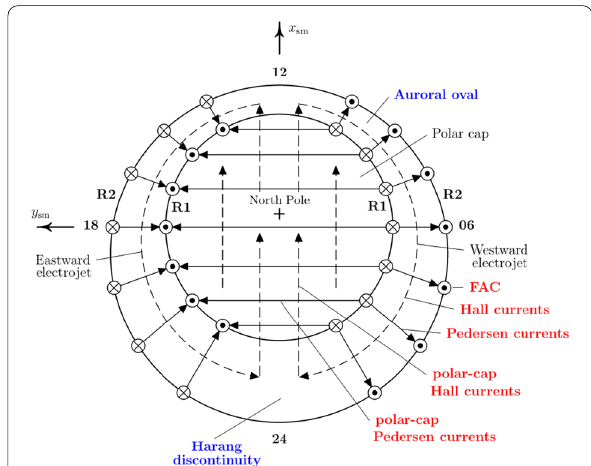
Fig. 6 A schematic view of large-scale current systems in the polar ionosphere of the northern hemisphere. The auroral oval (bounded by two eccentric circles) is the region with an enhanced electrical conductivity. FACs transport energy and momentum between the magnetosphere and ionosphere via Region 1 (the poleward edge of the auroral oval) and Region 2 (the equatorward edge of the auroral oval). Crossed and dotted circles represent the flow of FACs into and out of the ionosphere, respectively. Hall currents and polar-cap Hall currents (dashed lines) flow along the eastward and westward auroral electrojets, and sunwards across the polar cap, respectively. Pedersen currents and polar-cap Pedersen currents (solid lines) flow across the electrojets between Region 1 and Region 2, and across the polar cap to the opposite local-time sector,